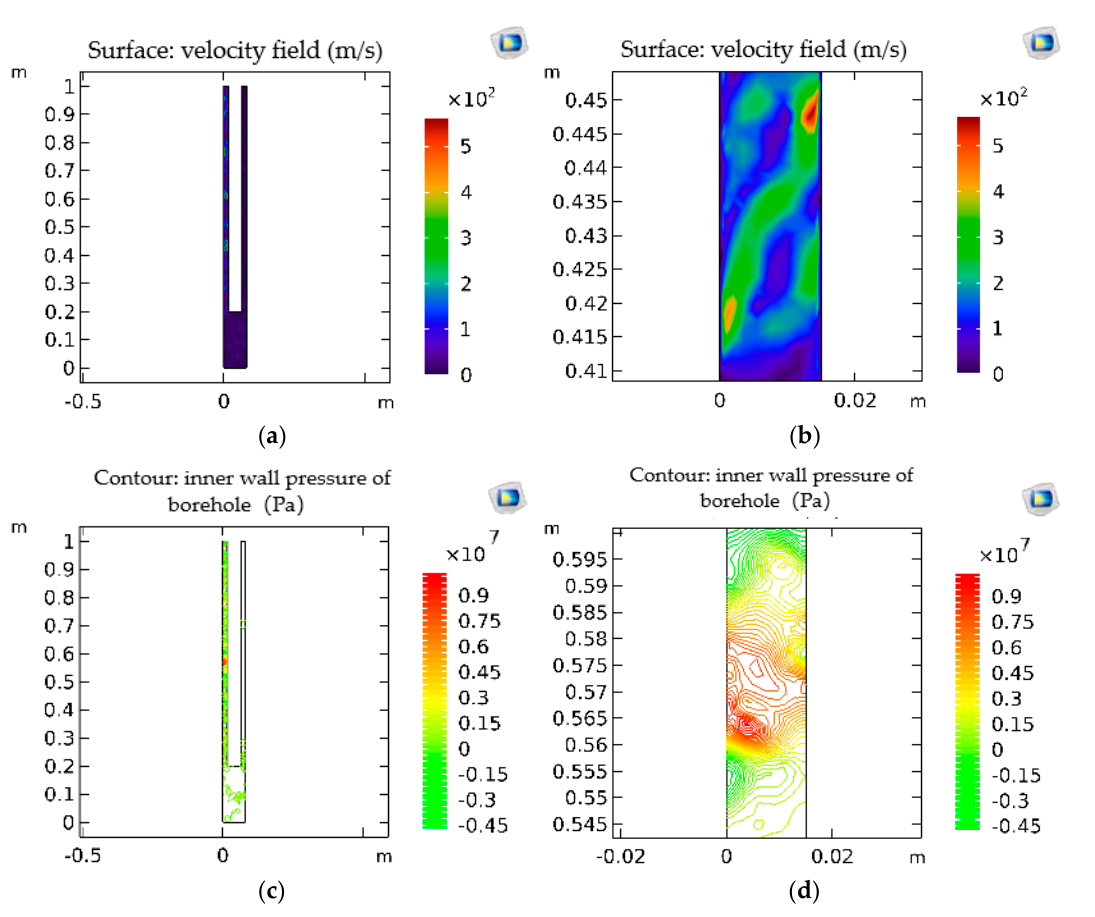
Figure 3. Fluid–solid coupling boundary state of 0.08 m borehole. ( a ) Surface velocity of inner wall of 0.08 m borehole. ( b ) Surface velocity of inner wall of 0.08 m borehole (velocity peak position). ( c ) Hole wall pressure of 0.08 m hole diameter. ( d ) Hole wall pressure of 0.08 m hole diameter (stress peak position).